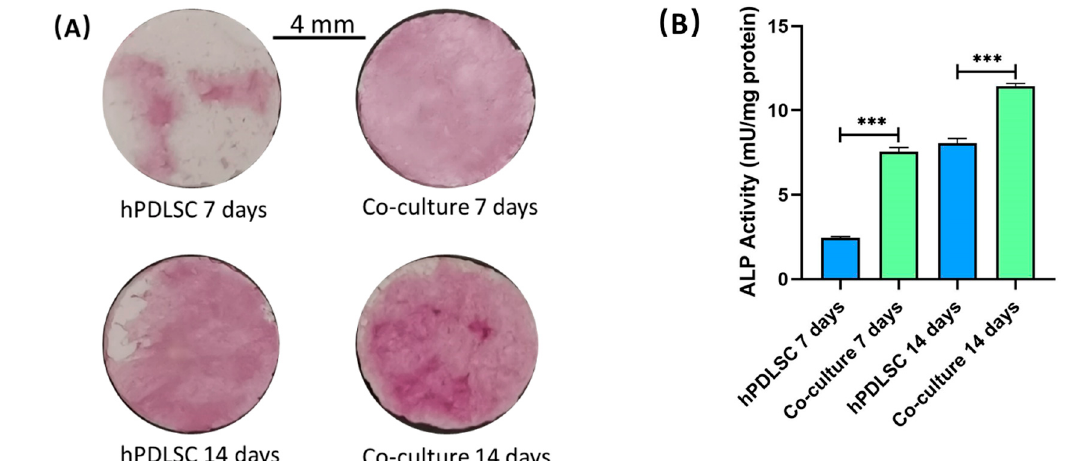
Figure 4. ( A ) ALP staining images of CPC scaffolds at 7 and 14 days. ( B ) ALP activity at 7 and 14 days. The images show that co-culture group has higher ALP expression than monocultured hPDLSCs. *** p < 0.001.